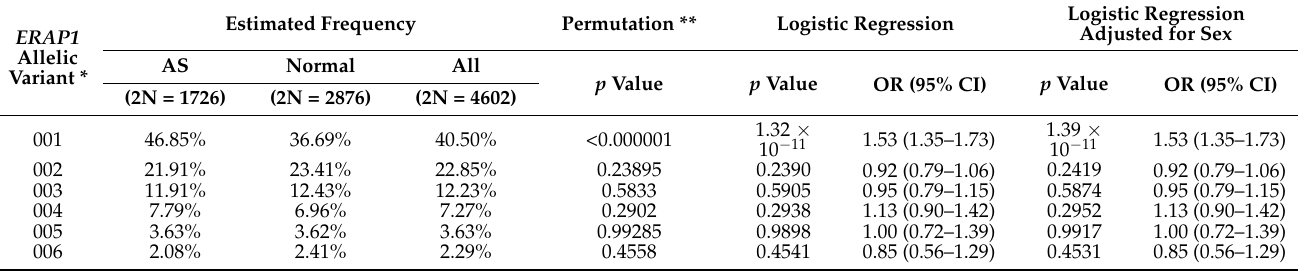
Table 1. Association of ERAP1 allelic variants with AS susceptibility in